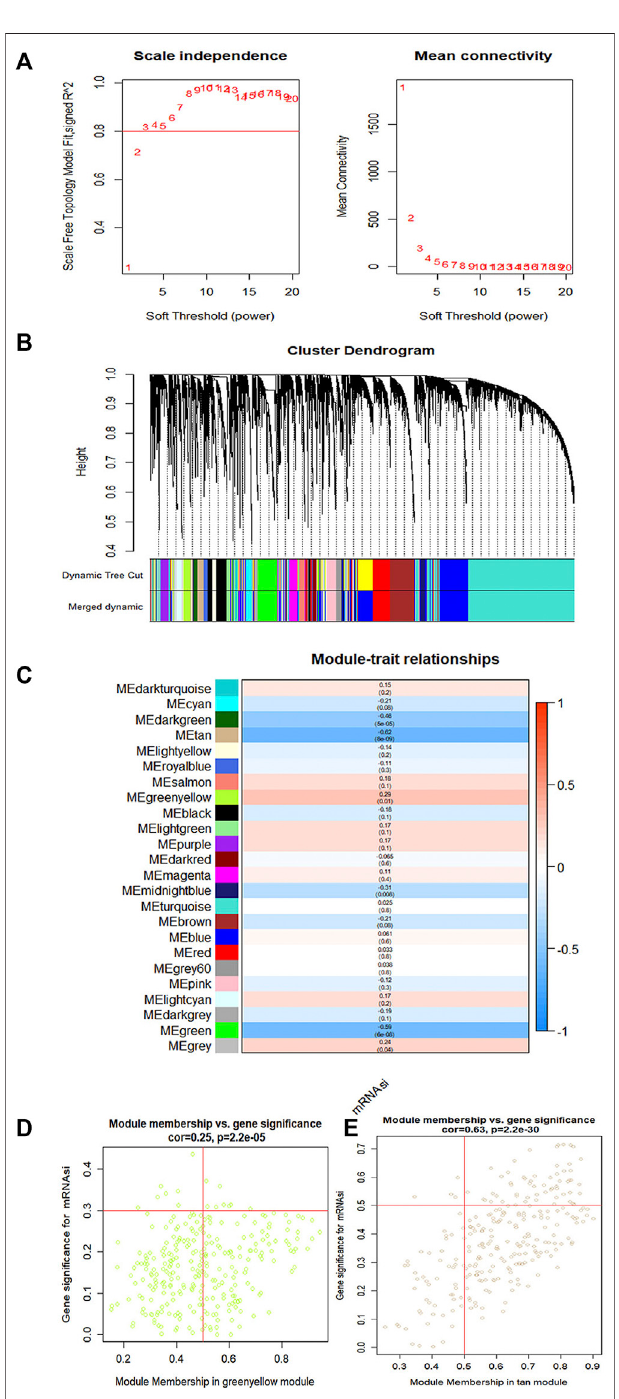
FIGURE 4 | The gene modules are identi fi ed by weighted gene co- expression network analysis (WGCNA) and related to the mRNAsi in ovary cancer. (A) The indexes are used to determine the power of weight in the co- expression network. (B) The branches of the cluster for the different gene modules. (C) The correlation between the gene modules and the mRNAsi. (D,E) Scatter plot showing the fi lter of key genes. Each scatter represents a gene. The gene correlated with a module (module membership) and mRNAsi together is considered as the key gene.